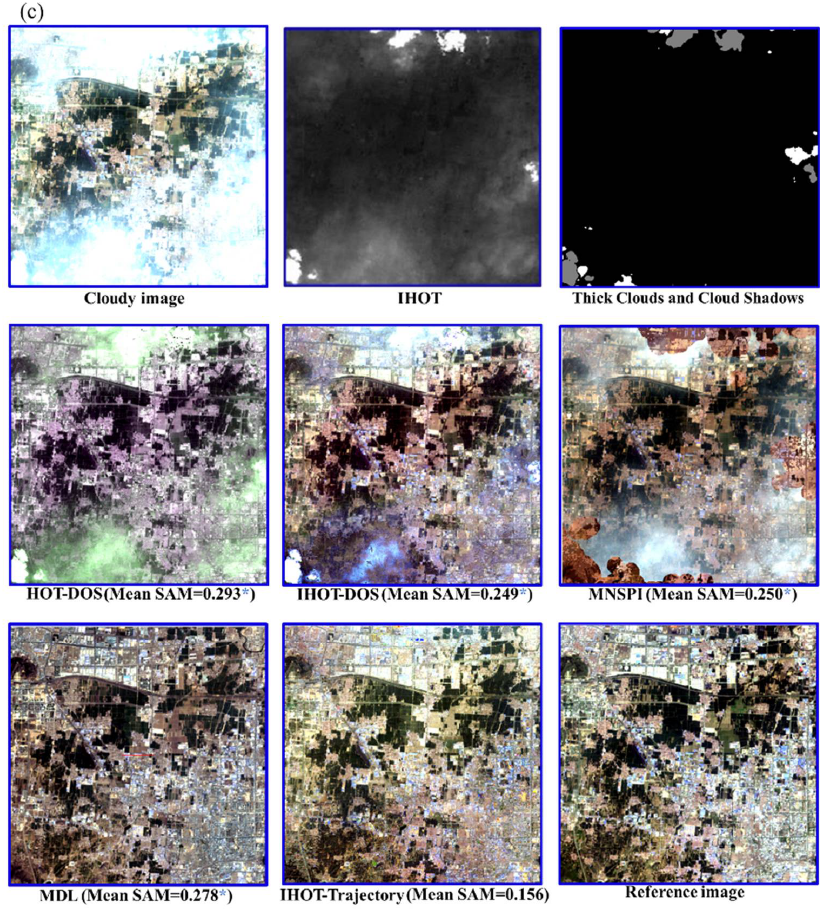
Figure 5. Cloud removal of Landsat image (122/34) acquired at 22 April 2014 ( a ) whole image; ( b ) enlarged images of the subset area; ( c ) enlarged images of the subset area.